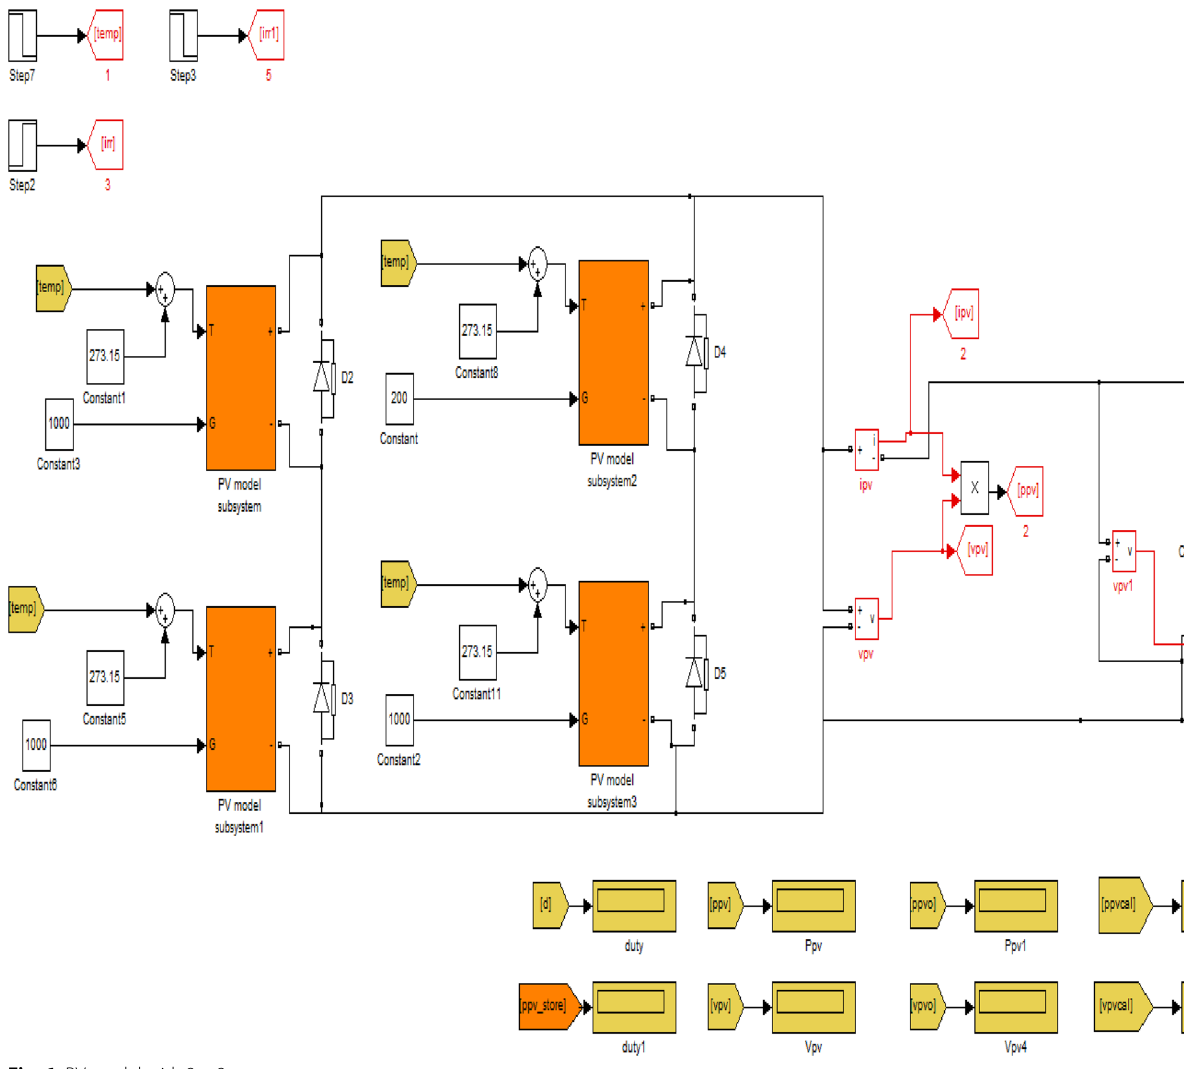
Fig. 6 PV model with 2